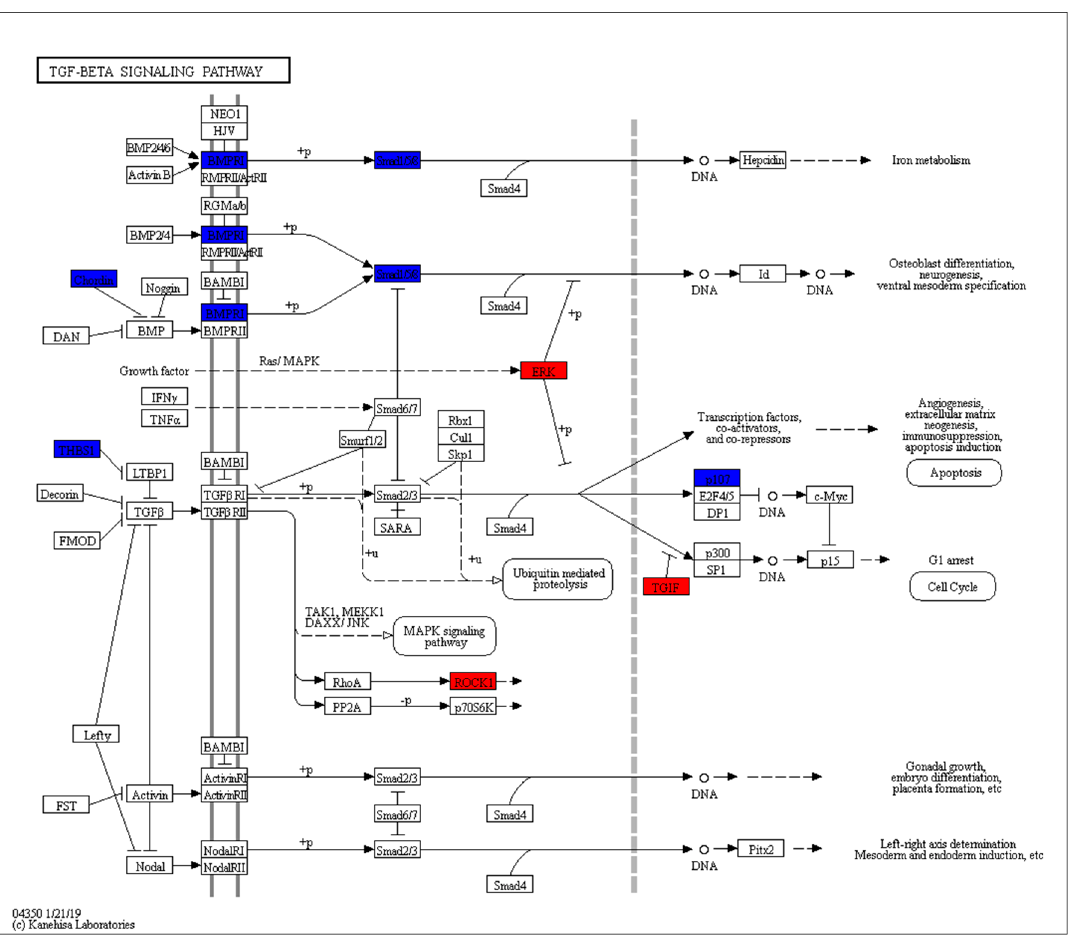
Figure 9. TGF- β signaling pathway. Red indicates up-regulated genes and blue indicates down- regulated genes.